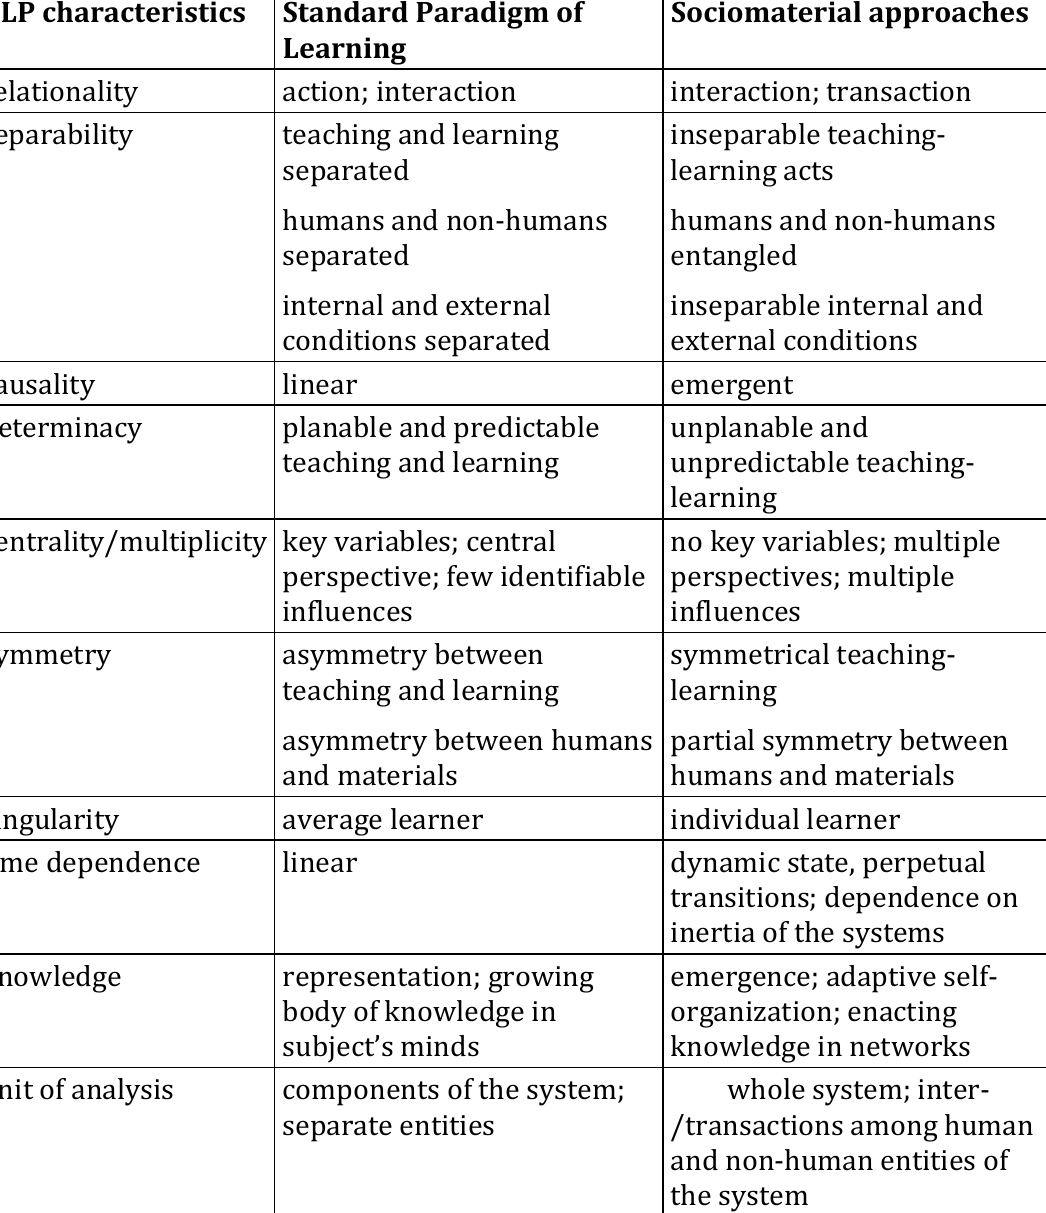
Table 1. Characteristics of teaching-learning processes as seen by two different